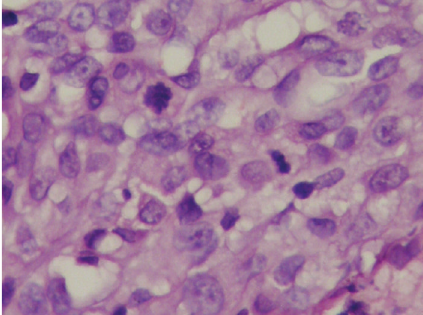
Figure 1: Plexiform fibrohistiocytic tumor showing multinodular mass in the subcutis (hematoxylin-eosin ×10 ).